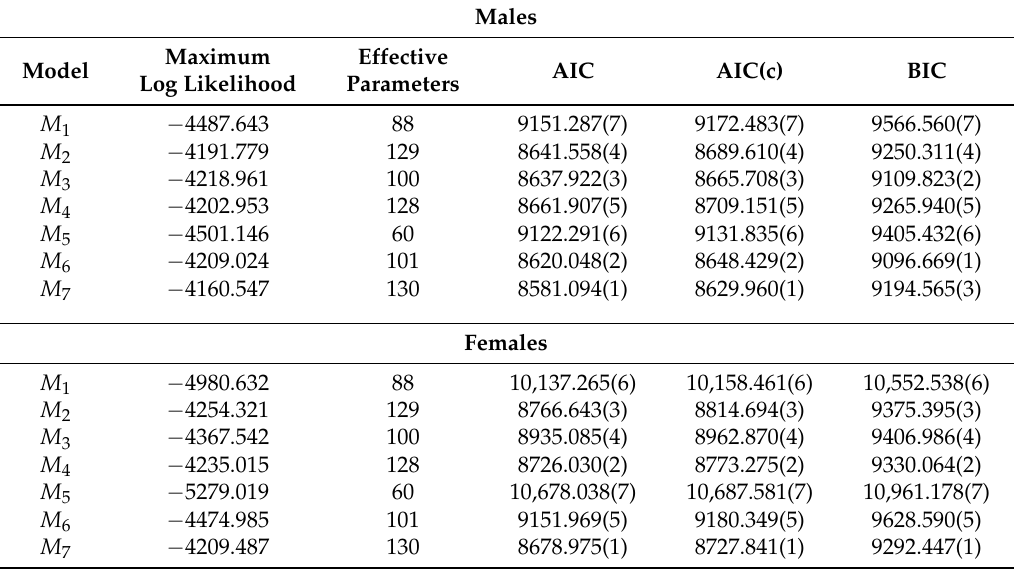
Table 2. The maximum log likelihood and the number of the effective parameters along with AIC(c), AIC and BIC values (ranking order in brackets) of the mortality models for males and